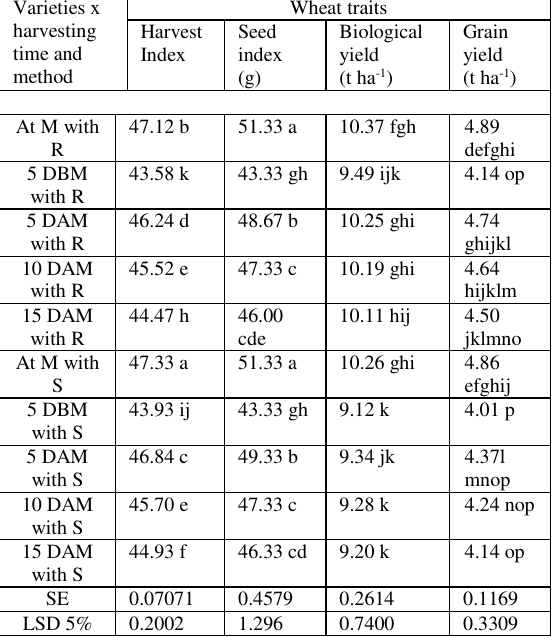
Table 3: Interactive effect of wheat cultivars X Harvesting time and method on yield traits Varieties x